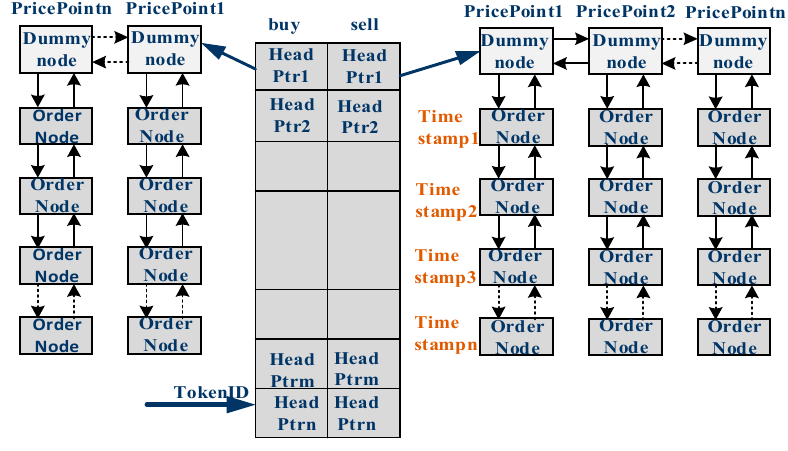
Figure 6. Securities pointer table.